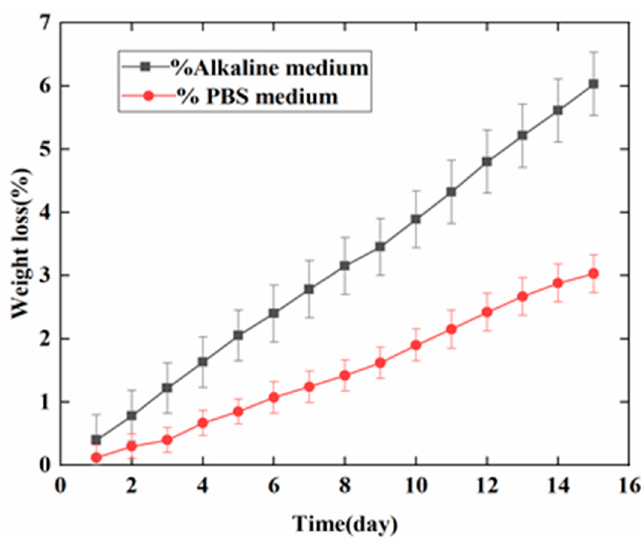
Figure 5. Weight loss of PAB in the alkaline and phosphate-buffered saline (PBS) media over 15